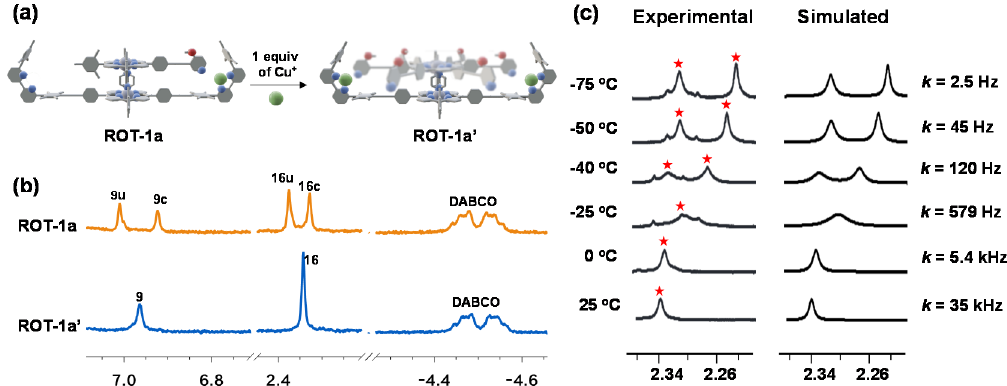
Figure 3. ( a ) Cartoon representation of ROT-1a and ROT-1a’ . ( b ) Comparison of partial 1 H NMR (CD 2 Cl 2 , 400 MHz, 298 K) of ROT-1a and ROT-1a’ . Protons in ROT-1a that correspond to the heteroleptic pyridine and phenanthroline (HETPYP)-complexed bipyridine (9c-H, 16c-H) are different from those that belong to the unloaded bipyridine (9u-H, 16u-H) and the averaged signals (9-H, 16-H) in ROT-1a’ . ( c ) Partial VT 1 H NMR (CD 2 Cl 2 , 600 MHz) of ROT-1a’ shows the splitting of the 16-H signal at low temperature (red asterisk).